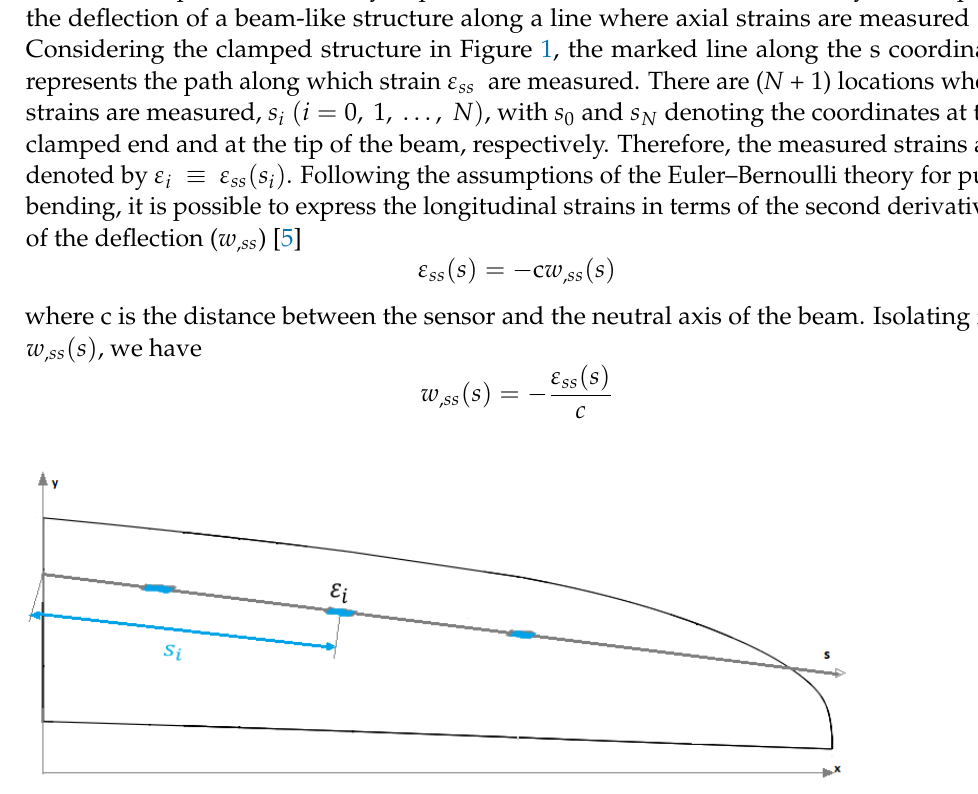
Figure 1. Half-wing with reference system and sensor markers.